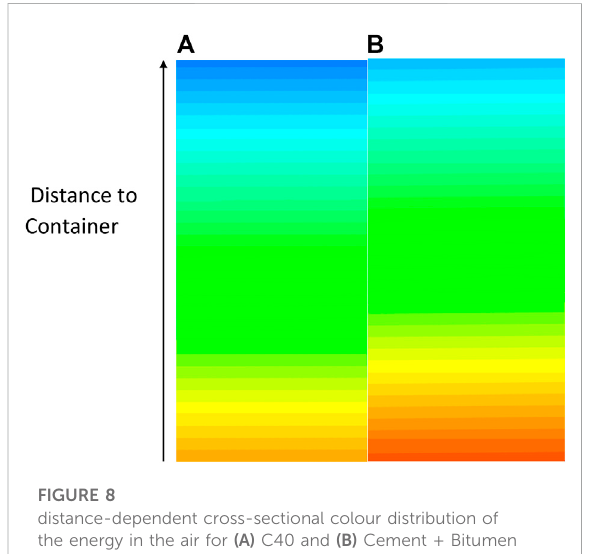
FIGURE 8 distance-dependent cross-sectional colour distribution of the energy in the air for (A) C40 and (B) Cement + Bitumen